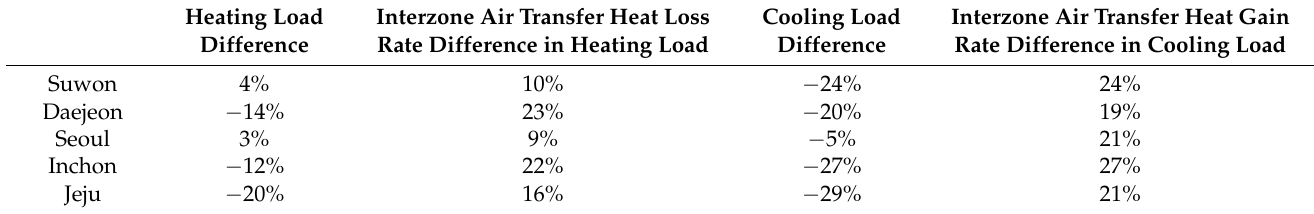
Figure 15. Comparison of the annual heating load the heat lost via transfer as calculated with the AFN model and the ACH model using weather data from several cities. Table 1. Difference in the results obtained with the AFN model and the ACH model for several